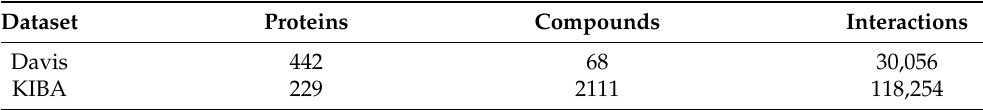
Table 6. Summary of the Davis and KIBA dataset.